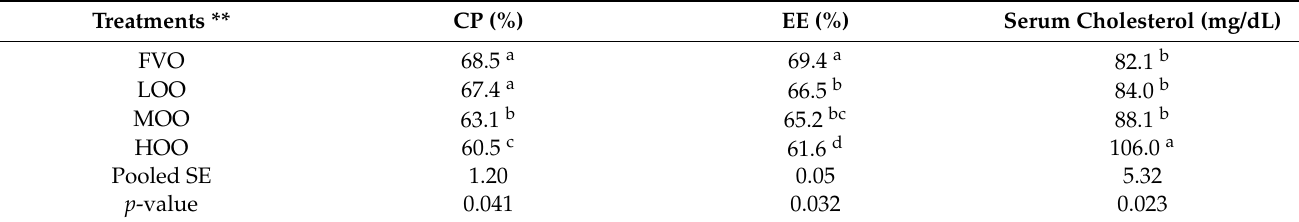
Table 4. Influence of oxidized vegetable oil on nutrients utilization of crude protein (CP), crude fat (EE) and serum cholesterol concentration in broilers